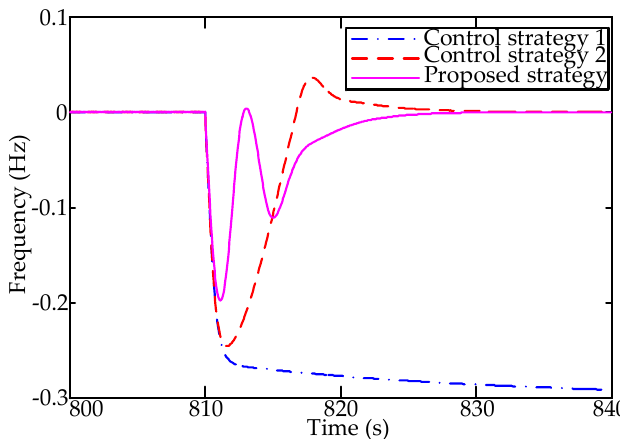
ff erent control schemes.